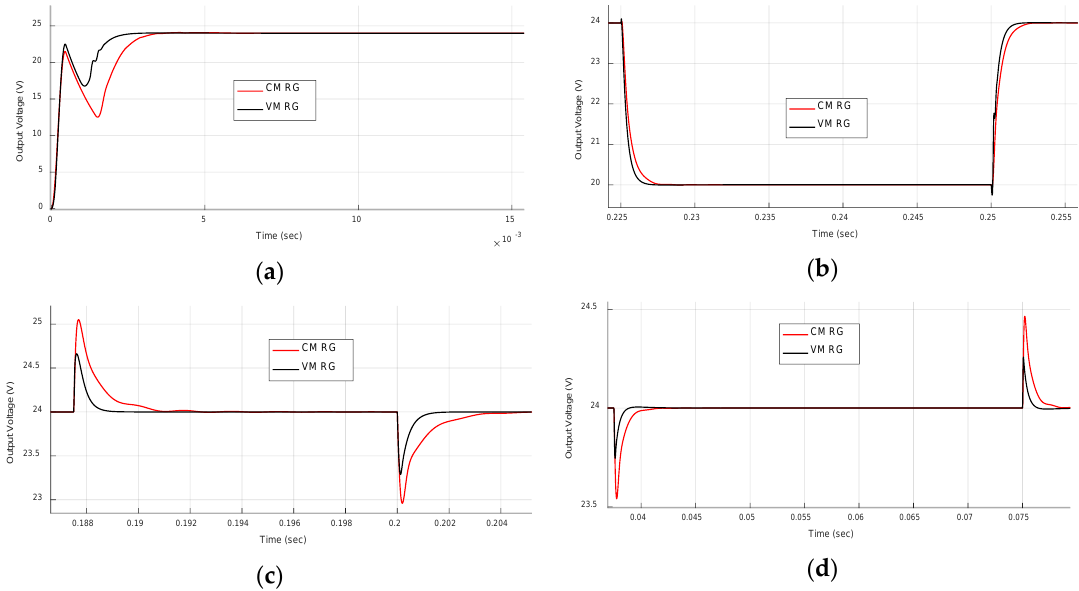
Figure 12. Comparative transient responses of voltage mode (VM RG) and current-mode reference governor (CM RG), with specs as in Tables 2 and 4. ( a ) Startup transient response for tracking a reference input of 24 V with an input voltage Vin = 12 V; ( b ) Reference input changes from 24 V to 20 V and back; ( c ) rejection of load step changes (from 10 to 50 Ω and back); ( d ) dealing with step changes in the input voltage (from 12 to 10 V and back).